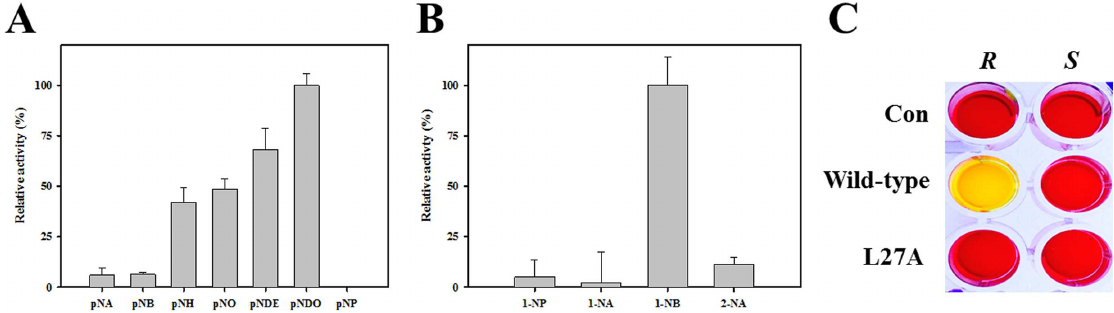
Fig 9. Analysis of substrate profiles and enantioselectivity of the L27A mutant. Substrate profiles of L27A were investigated toward different p -nitrophenyl esters (A) and naphthylderivatives(B). (C) pH shift assay was conductedin the presenceof ( R )- or ( S